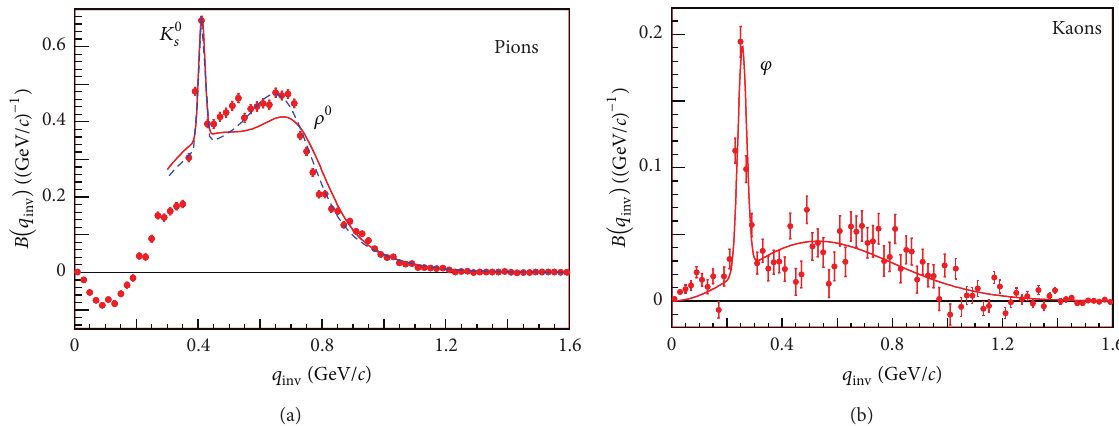
Figure 4: The balance functions are given in terms of 𝑞 for charged pion pairs in panel (a) and charged kaon pairs in panel (b) from pp inv = 200 GeV integrated over all multiplicities. The graph is taken from collisions at √𝑠 NN